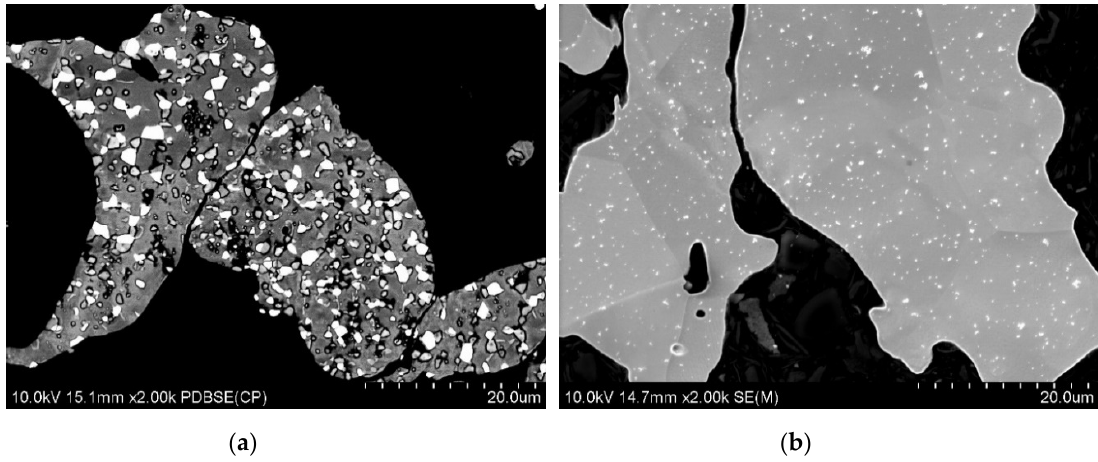
Figure 2. Microstructure of powders: ( a ) M3/2 high speed steel, ( b ) NC 100.24 iron; SEM.